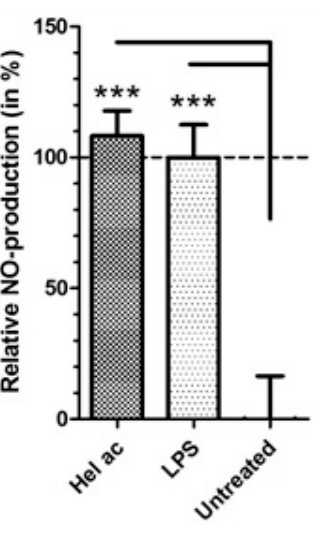
Figure 5. Production of nitric oxide (NO) by peritoneal macrophages of BALB/c mice treated with helenalin acetate ( 1 ). The production of NO was determined colorimetrically by the Griess assay. The data were blanked and normalized to the value of control cells (untreated macrophages); 1 × 10 5 macrophages/well were incubated with ( 1 ) at 3 μ M for 24 h. Untreated = Untreated macrophages; lipopolysaccharide (LPS) = 5 µ g/mL lipopolysaccharide (positive control); Hel ac = helenalin acetate ( 1 ). Error bars depict the mean and SD of duplicate samples. *** α = 0.001. One representative of two independently performed experiments is shown.